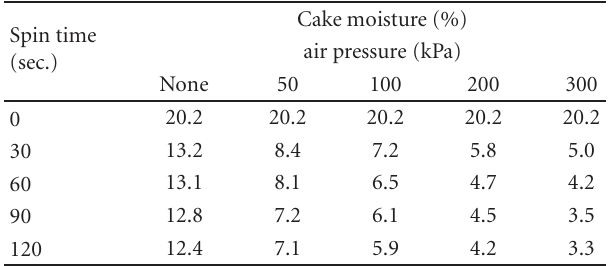
Table 3: E ff ects of G -force and air pressure on the